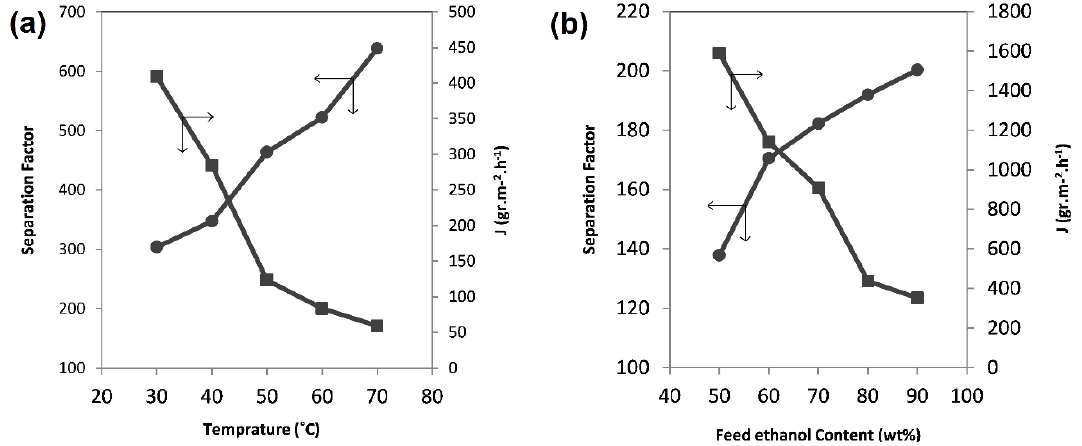
Figure 6. The pervaporation performance of the S6 membrane in different ( a ) temperatures; ( b ) feed ethanol content.